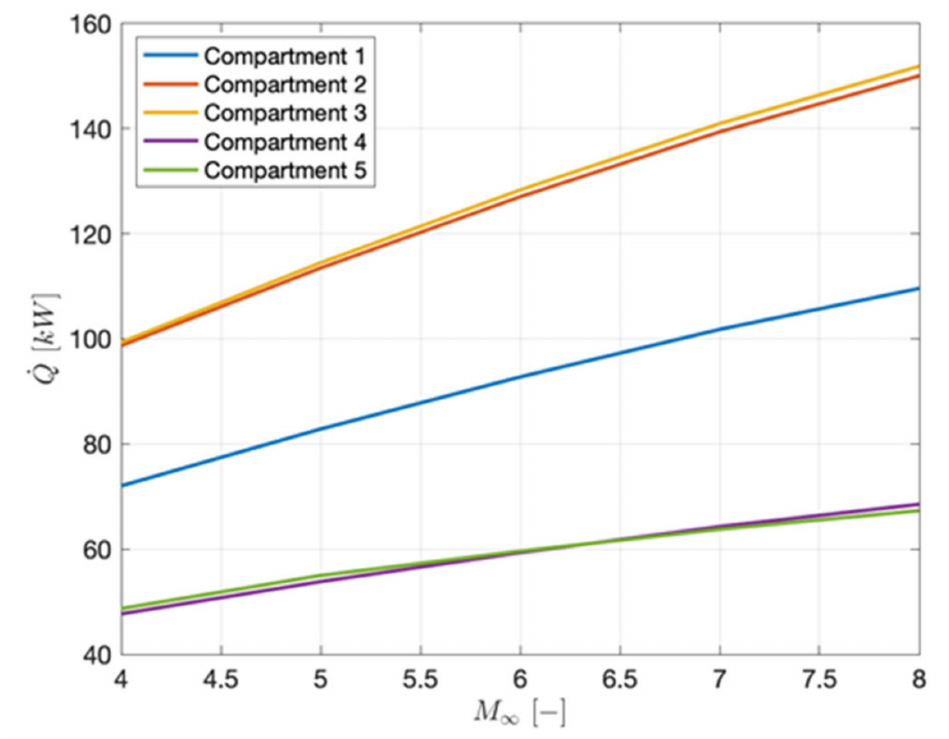
Figure 17. Variation of total heat load with the Mach number per each compartment for fixed values of thickness and speed of the boil-off hydrogen insulation